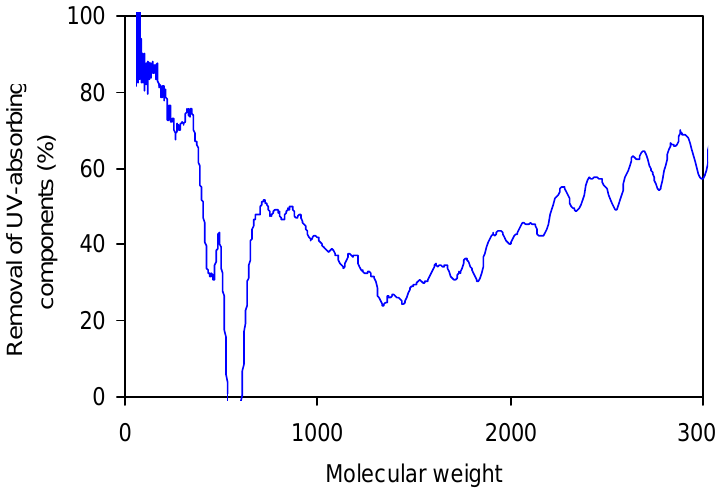
Figure 4. Percentage change in UV signal (at 254 nm) with molecular weight after the biological treatment